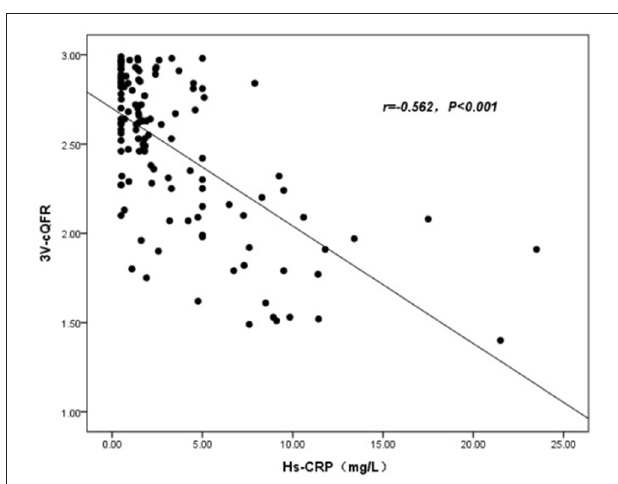
FIGURE 4 | Association analysis between 3V-cQFR and